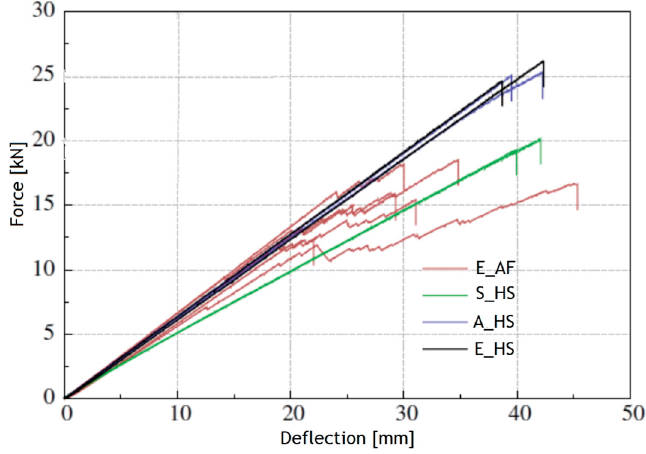
Figure 22. Beam tests TGIB-fg [18] (E—epoxy (3M DP490), S—silicone (Sika Sil SG500), A—acrylate (Sika Fast 5215) adhesive; AF annealed, HS heat strengthened float glass).